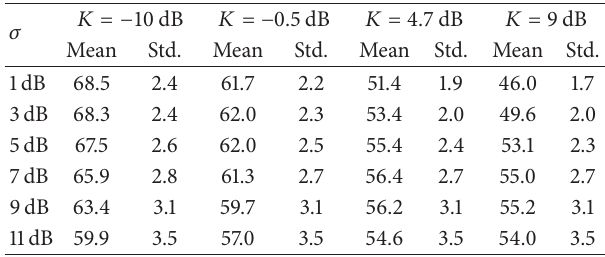
Figure 7: Histogram of different 10×10 MIMO systems with SNR = 30 dB.